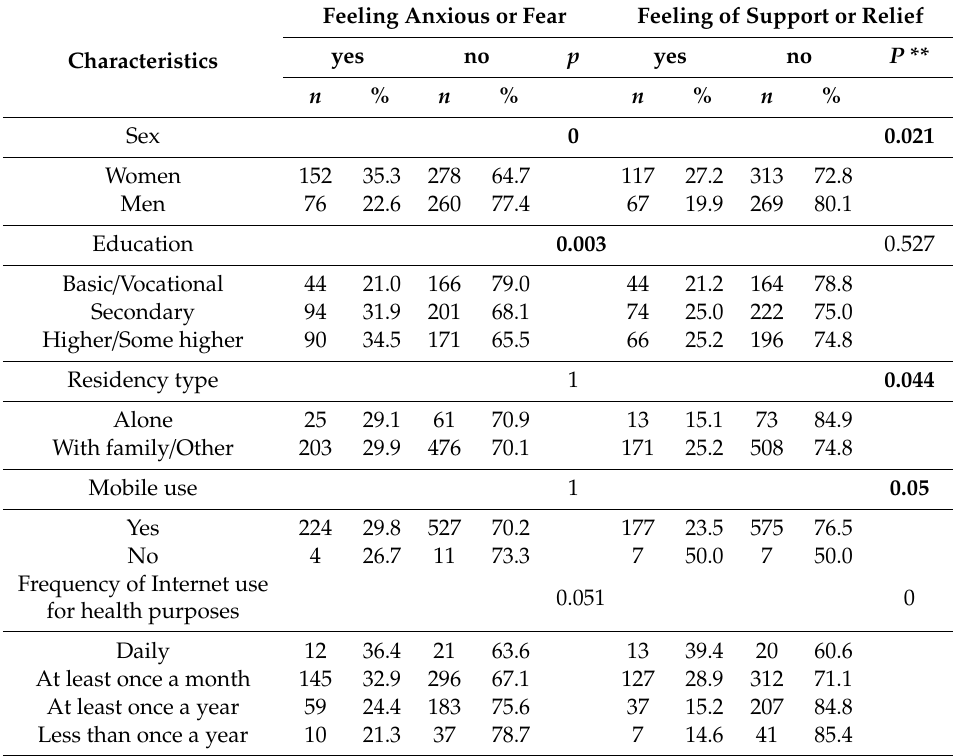
Table 4. Emotions triggered by health or disease information obtained from the Internet*. Feeling Anxious or Characteristics